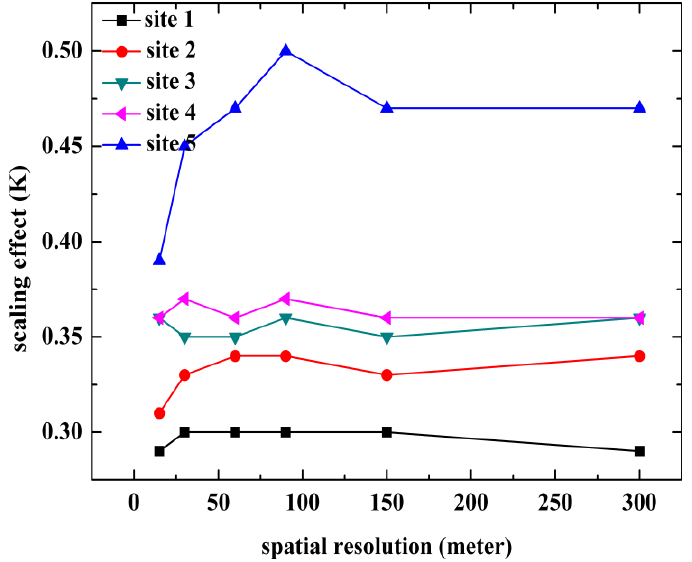
Figure 9. Relationship between the spatial resolution and the LST scaling effect after the scaling correction. The distributed LSTs were upscaled using Method